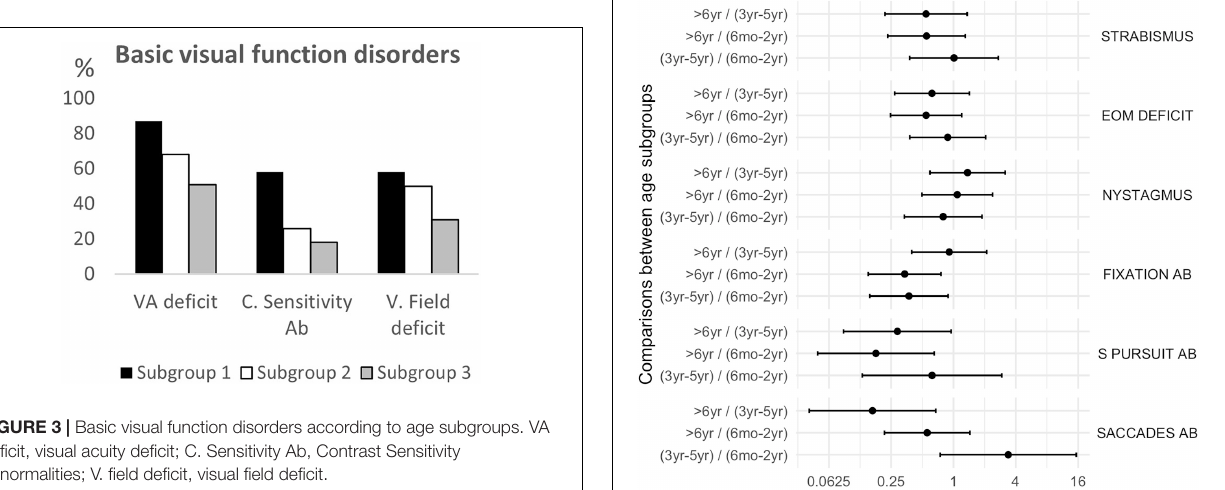
significantly differed for esotropia ( p = 0.02), and alteration of smooth pursuit ( p = 0.03) and saccades ( p < 0.01), more frequently present in subgroup 2.